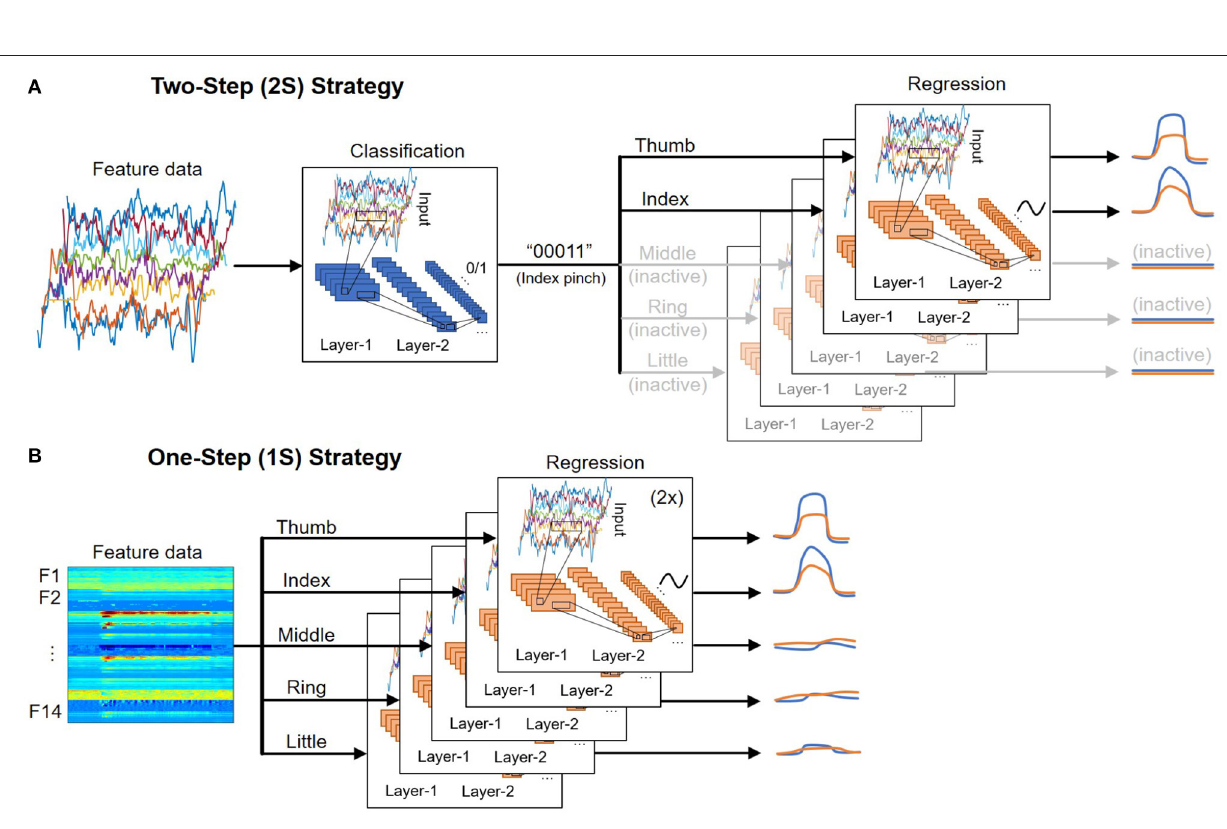
Frontiers in Neuroscience |